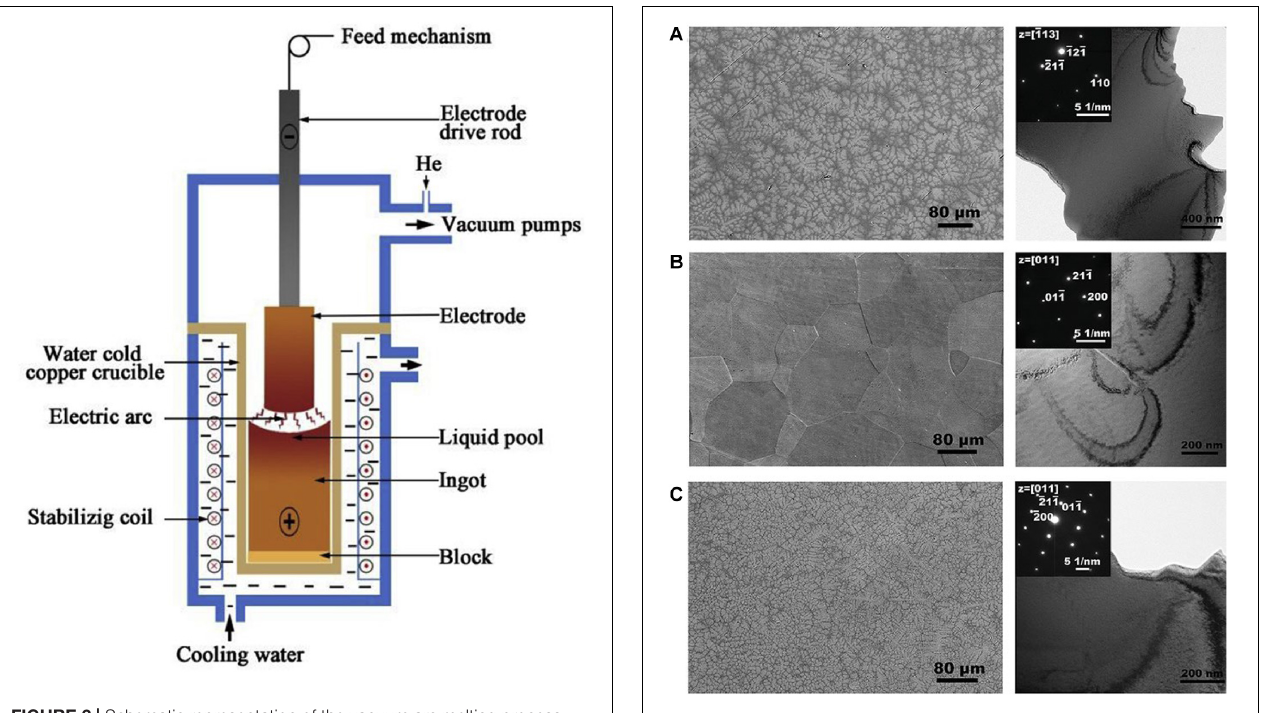
FIGURE 2 | Schematic representation of the vacuum arc melting process (Feng et al., 2020). Reproduced from Feng et al. (2020) with permission. FIGURE 3 | SEM images and TEM bright-field micrographs of three TiZrNbTa HEAs. (A) Ti 25 Zr 25 Nb 25 Ta 25 (B) Ti 45 Zr 45 Nb 5 Ta 5 (C) Ti 15 Zr 15 Nb 35 Ta 35 HEA (Yuan et al., 2019). Reproduced from Yuan et al. (2019) with permission.